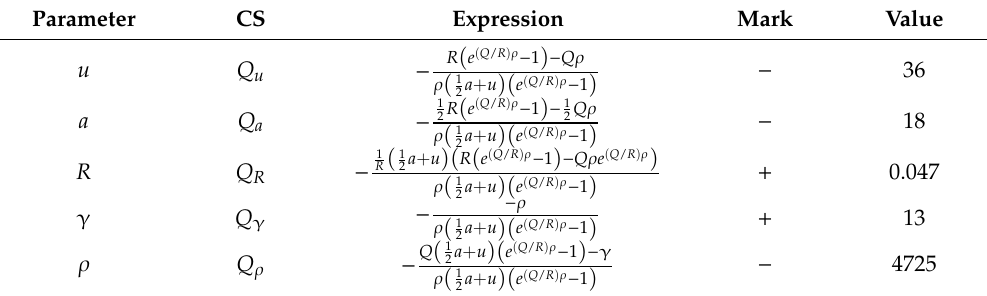
Table 1. Results analysis of comparative